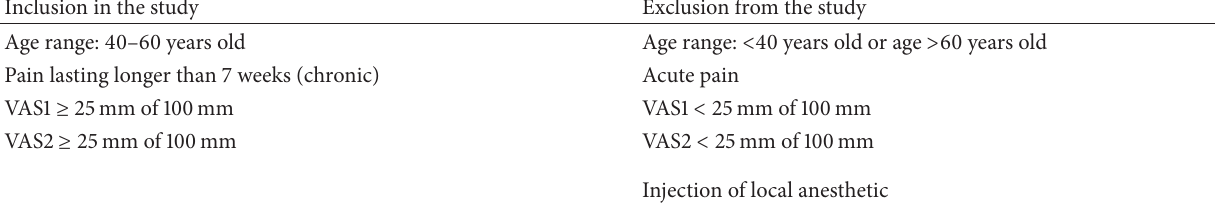
Injection of local anesthetic Patients after surgical procedures around spine or in the abdominal area Neurological signs present Compression of spinal nerve root confirmed by specific imaging techniques: computer tomography, myelography, or magnetic resonance imaging Other diagnostic techniques, for example,